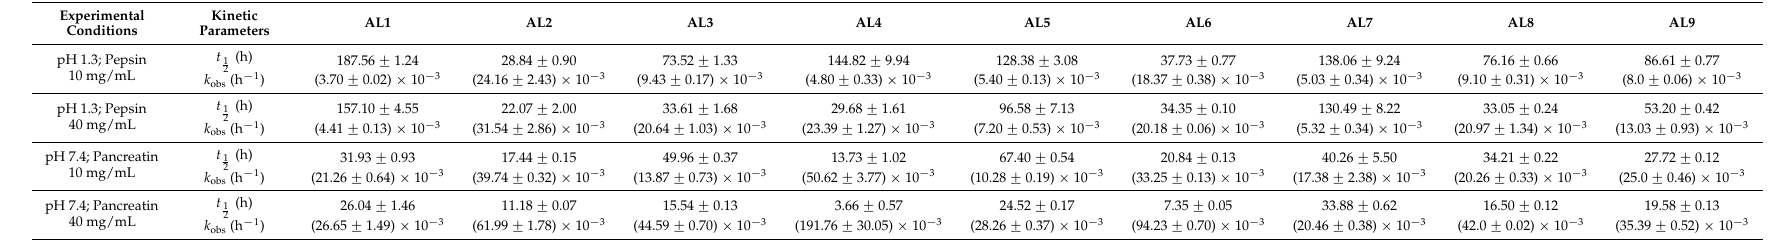
Table 1. Enzymatic stability studies of AL1 – 9 a .